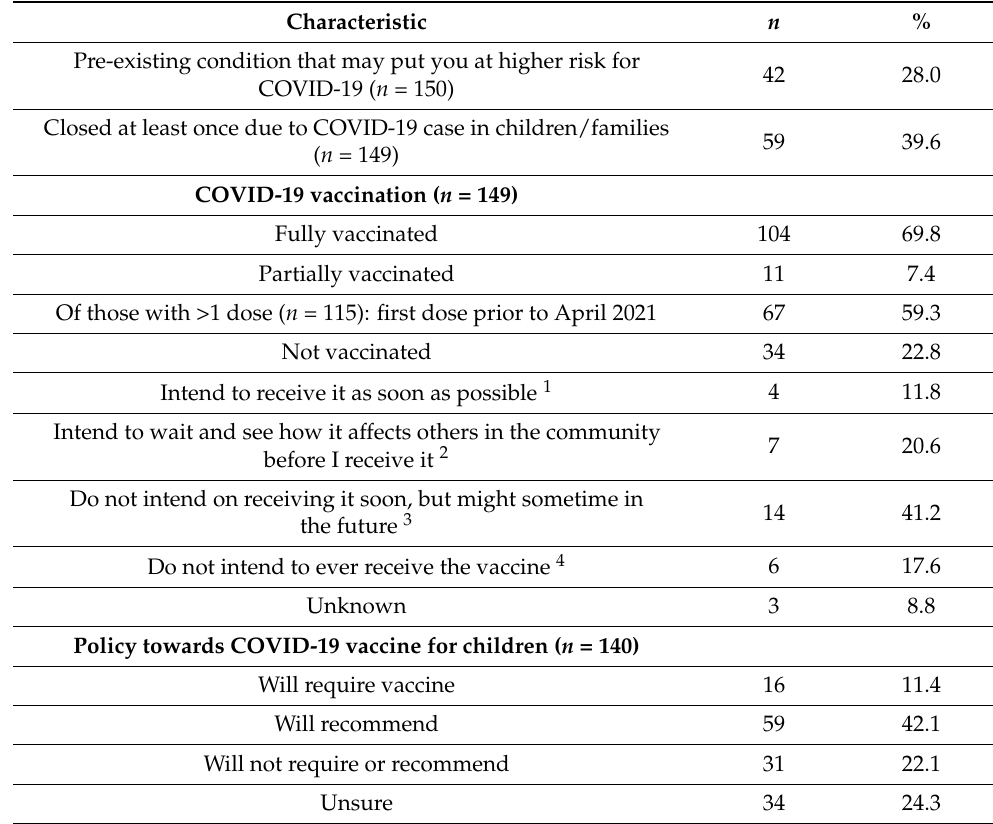
Table 1. Cont. Characteristic Pre-existing condition that may put you at higher risk for